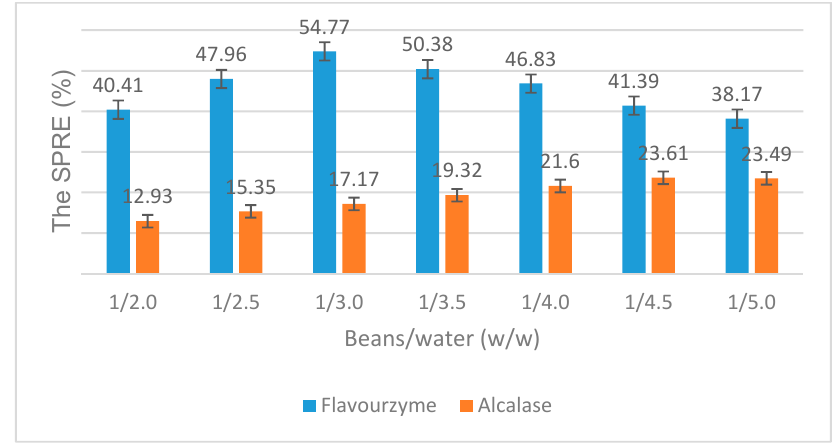
Figure 8. The effect of the beans/water ratio on the SPRE. Figure 8. The e ff ect of the beans / water ratio on the